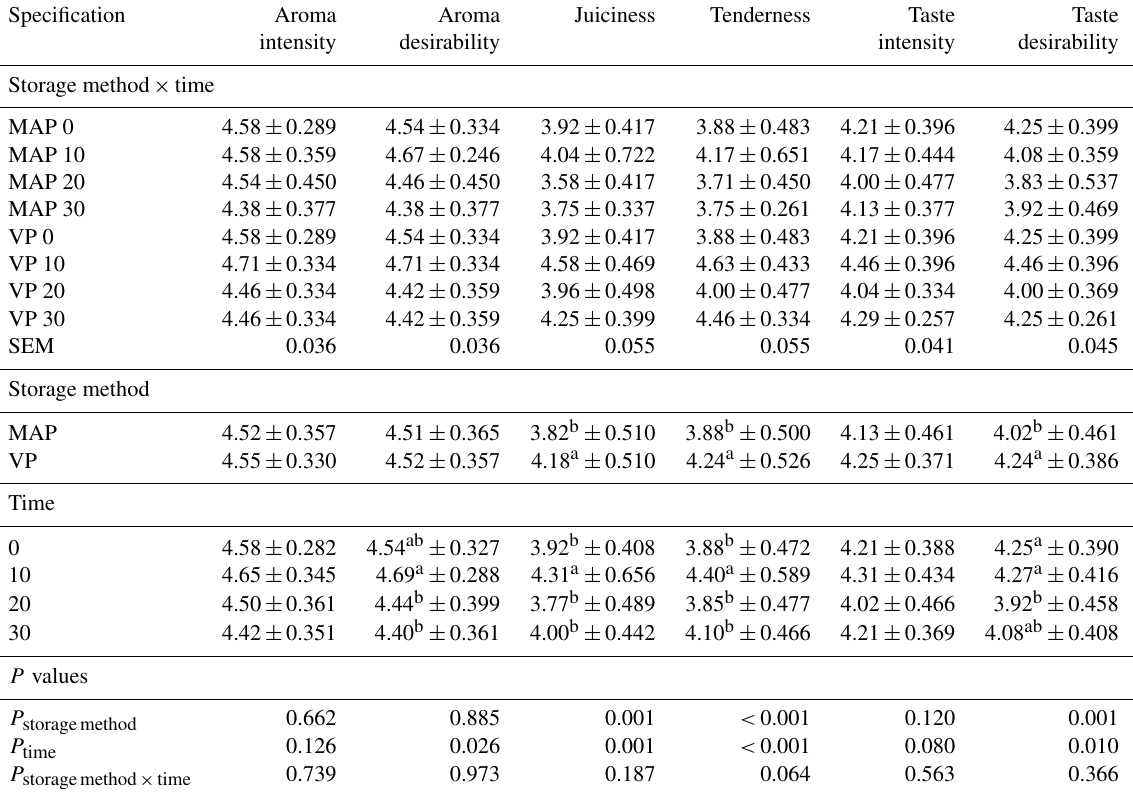
Table 5. Effect of vacuum packaging and modified atmosphere packaging on the sensory properties of lamb meat during storage at 4 ◦ C. Specification Aroma Aroma Juiciness Tenderness Taste Taste intensity desirability intensity